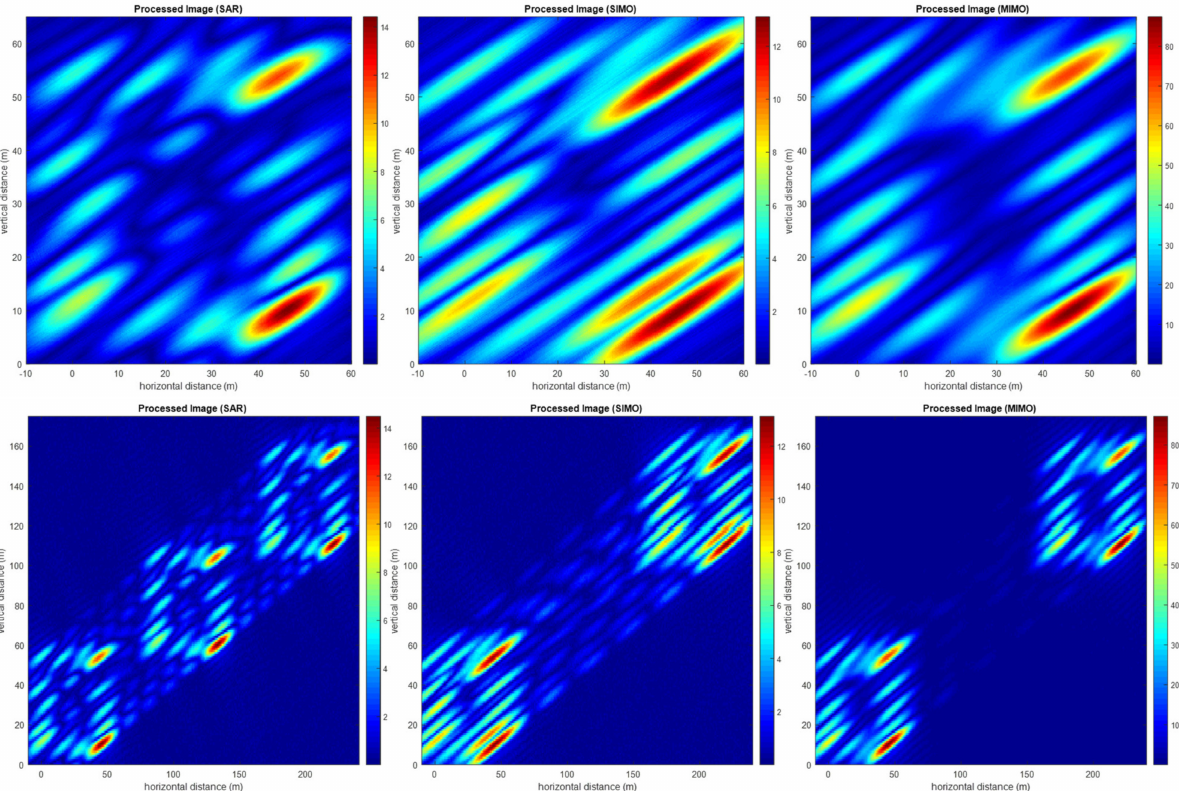
Figure 30. The simulated 2D images for Example 7 for SAR/SIMO/MIMO modes. Upper row: fine scene resolution (20 cm), small scene extent. Lower row: coarse scene resolution (1 m), large scene extent.